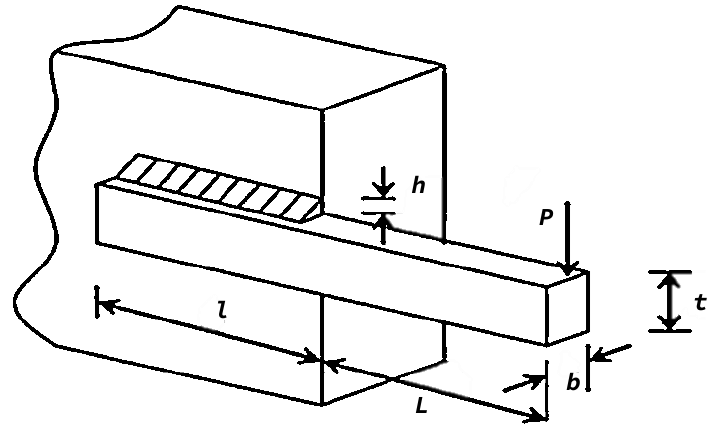
Figure 3. Welded beam design